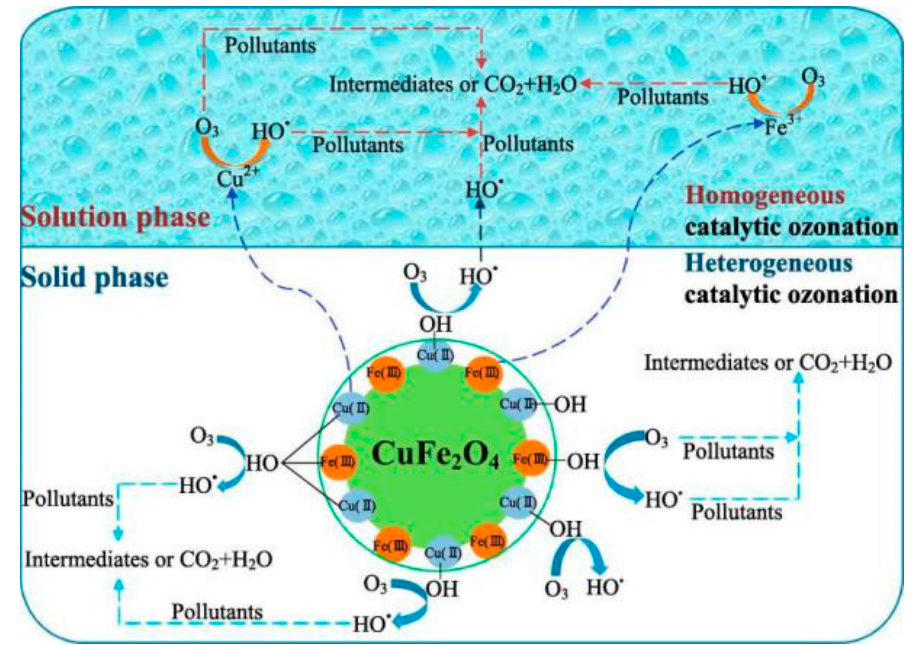
Figure 8. Possible reaction mechanism of the CuFe 2 O 4 /O 3 process.